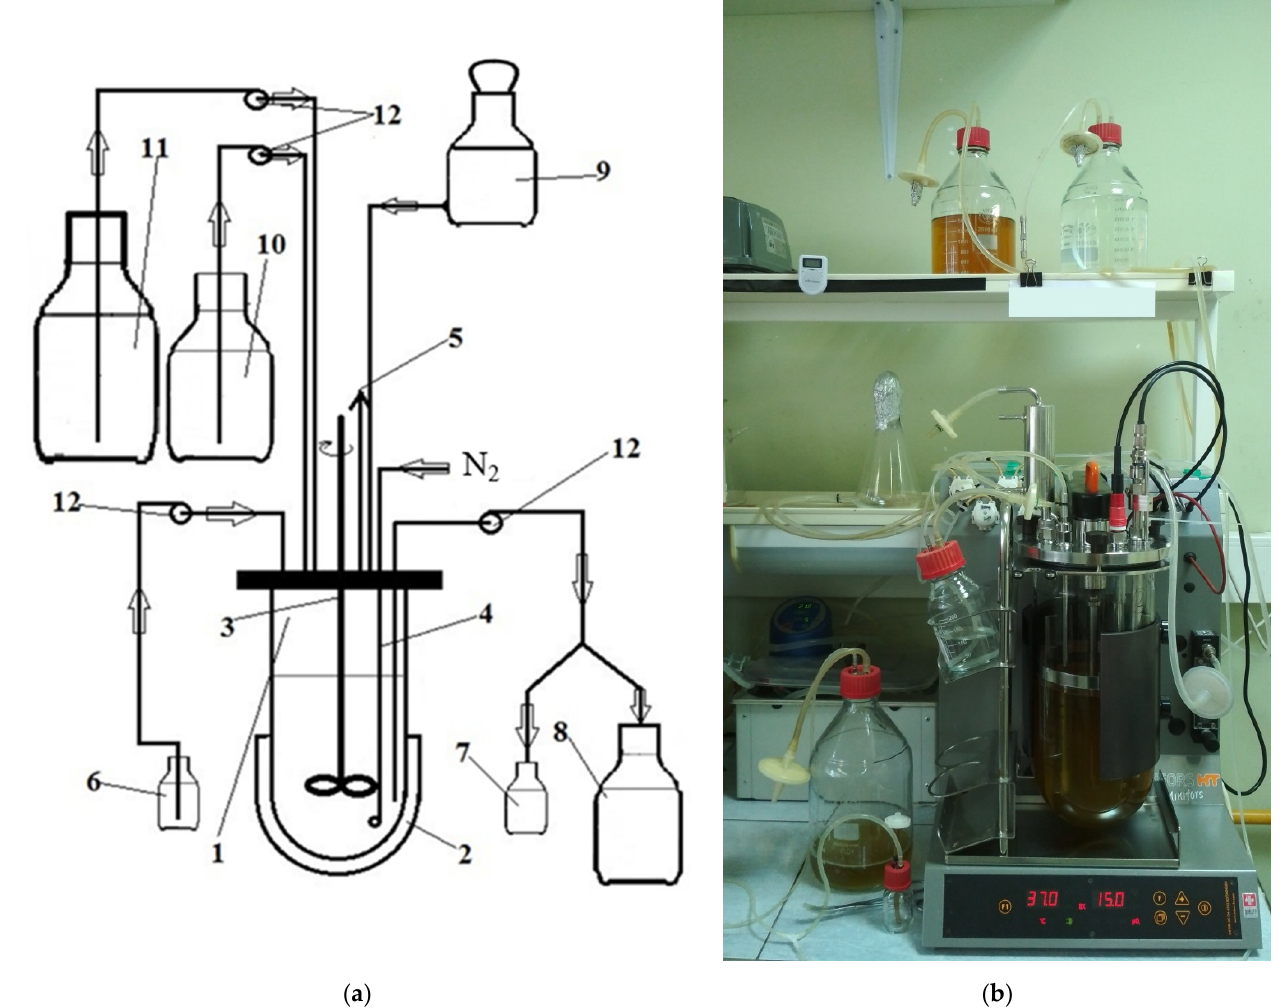
Figure 1. Schematic ( a ) and image ( b ) of the unit used for the simulation of descending colon con-